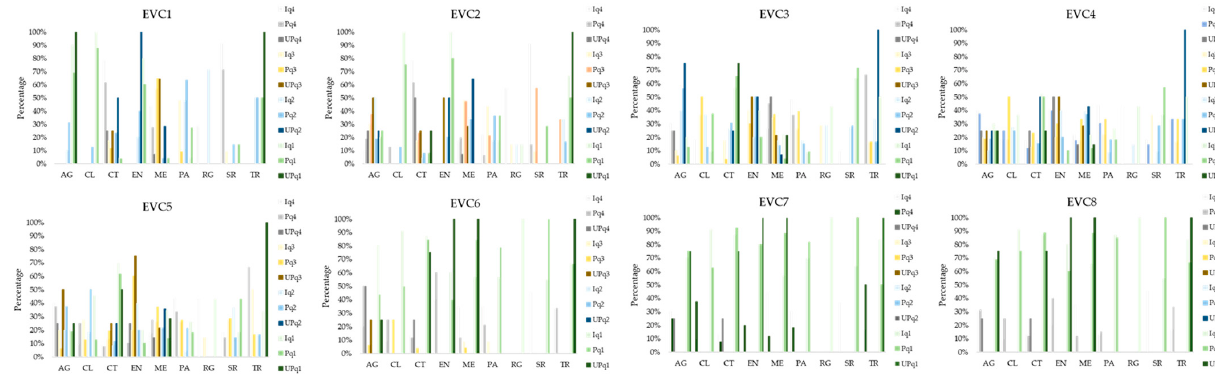
Figure A4. Comparison of the percentages of municipalities for different metropolitan cities in Sicily based on the quartiles of indicators for environmental and natural capital, and the NSIA classifica- tion. (Authors’ elaboration.) Appendix B Appendix B.1. Results on PCA: Total Variance Explored Table A1. Ranking of municipalities based on abandonment index for nine metropolitan cities in Sicily.